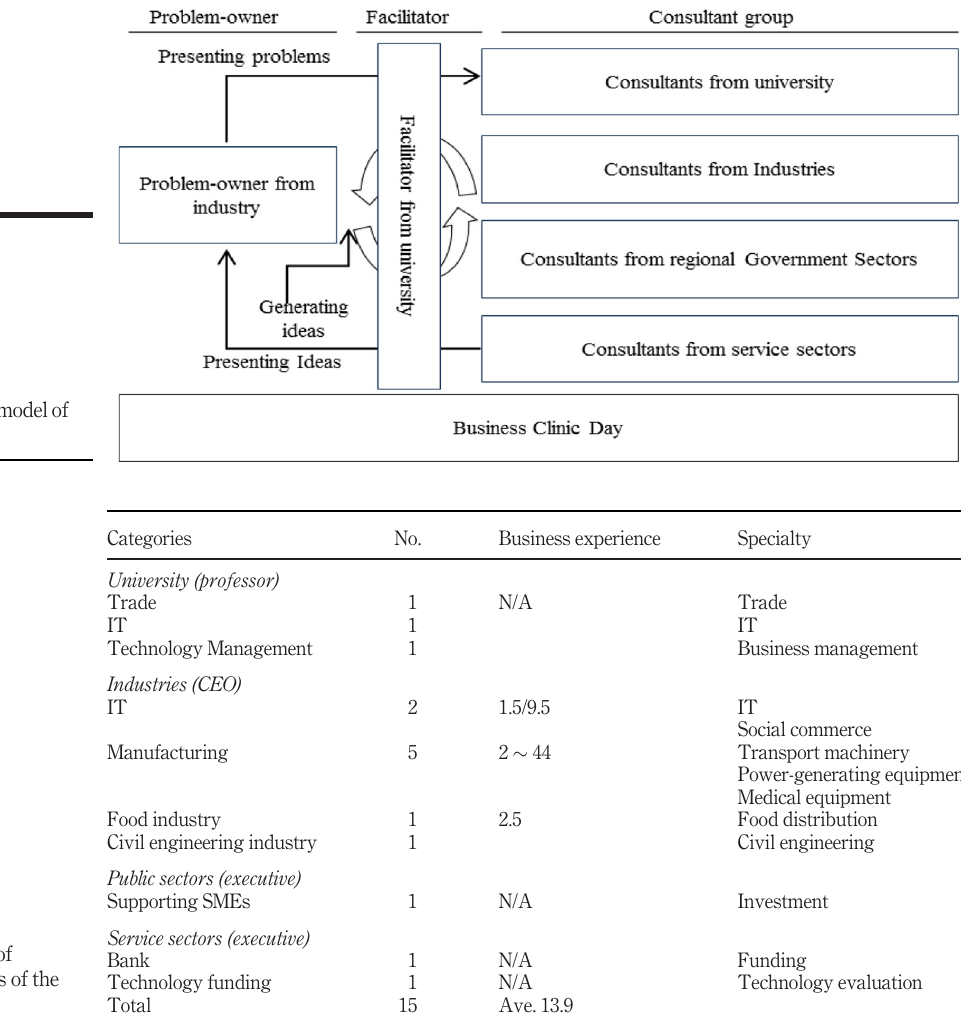
consultants of the